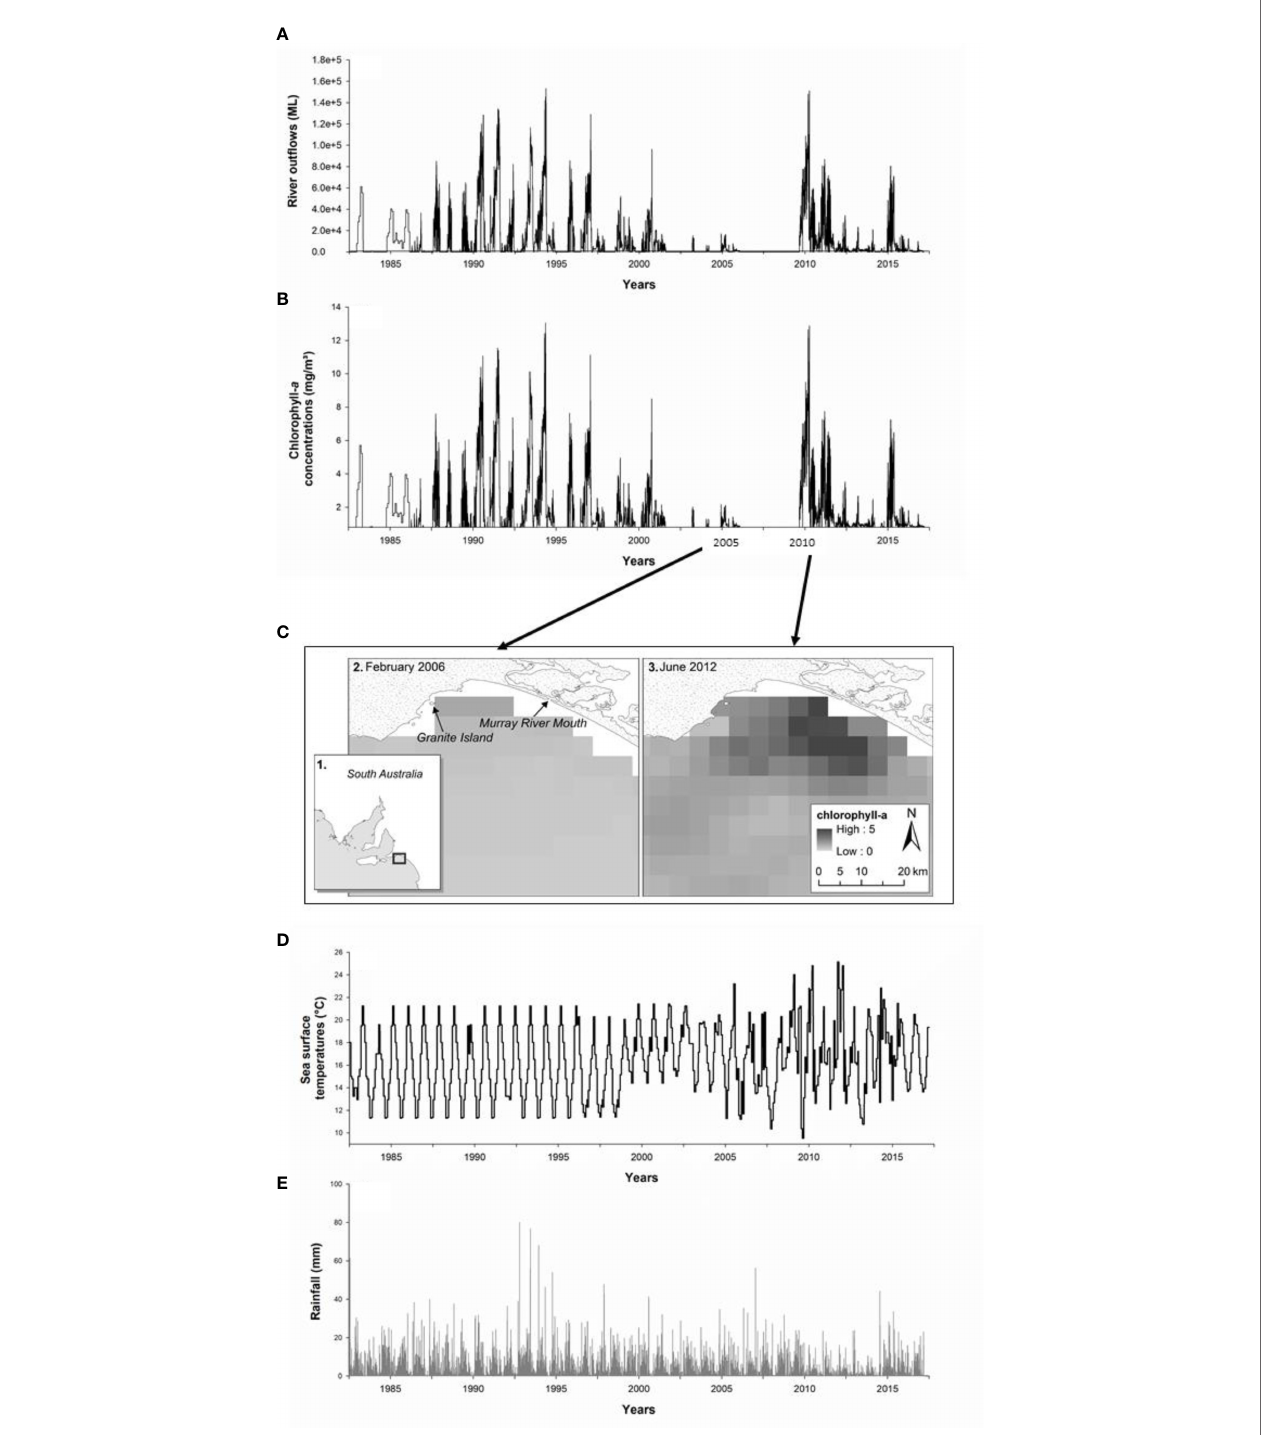
FIGURE 3 | (A) Daily river out fl ows (ML) from the Murray Mouth to the coastal ocean. (B) Monthly chlorophyll- a concentrations (mg/m³) within a 20 km radius of the Murray Mouth (C) Frame (1) shows the location extent of a comparison of MODIS-Aqua (monthly composite) satellite imagery products showing chlorophyll- a concentrations in during (2) a low fl ow period of February 2006 and (3) a high fl ow, post drought period in June 2012. (D) Monthly sea surface temperatures (°C) of the ocean surrounding Granite Island within a 20 km radius. (E) Daily rainfall (mm) for Granite Island. Data for (A, B, D, E) are presented from January 1981